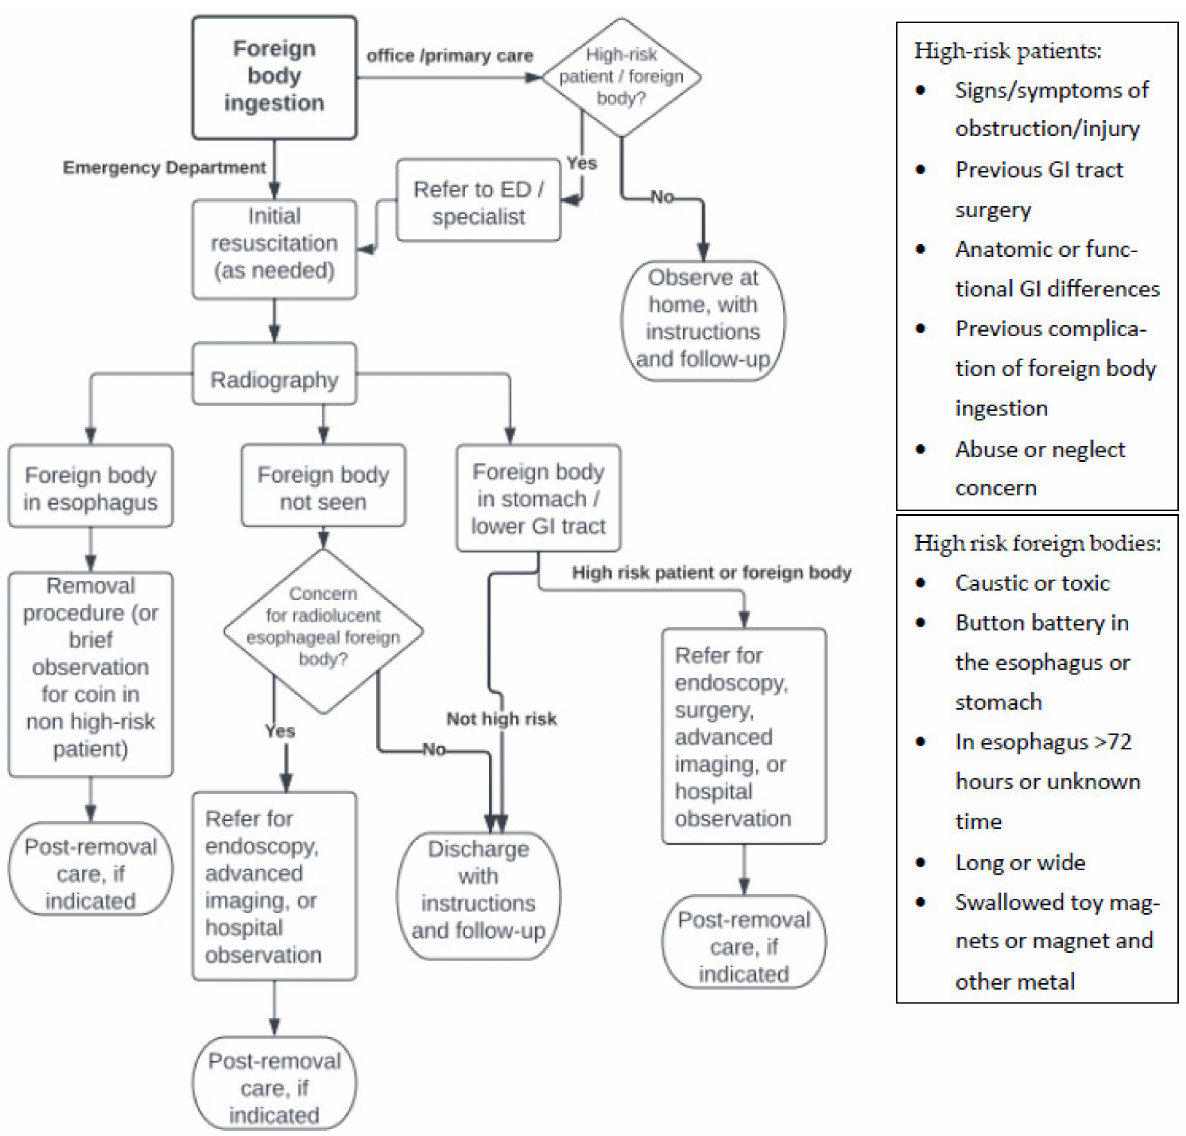
Figure 5. Flow diagram of general management of pediatric foreign body